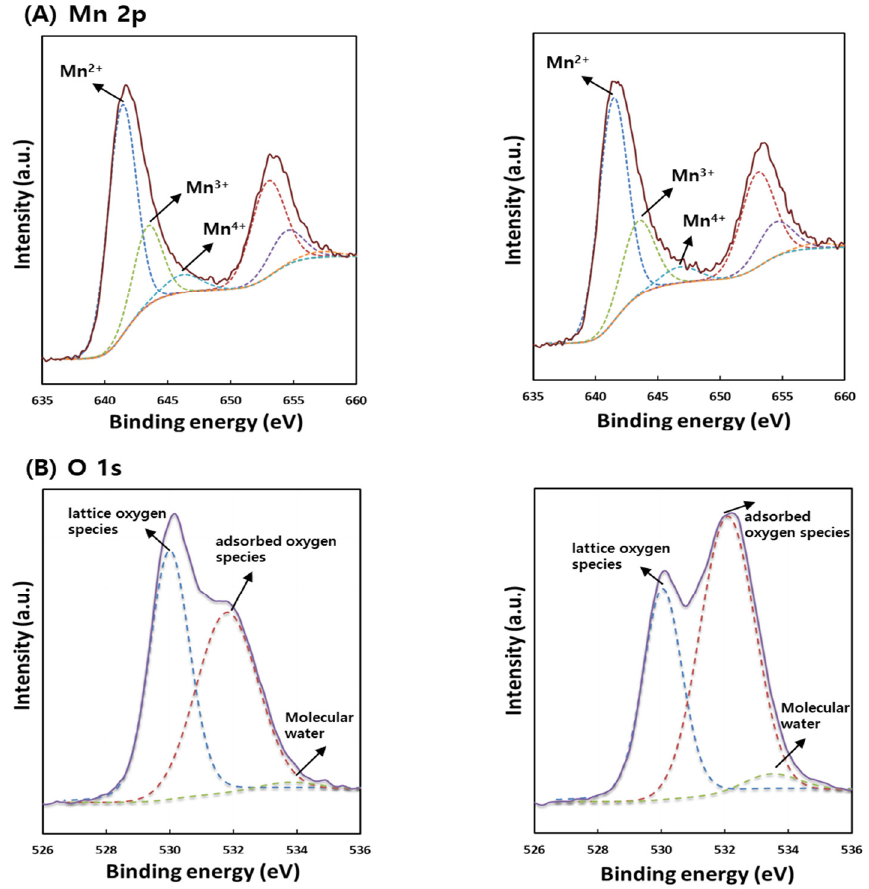
Figure 2. Curve fitting of the Mn 2p and O 1s XPS spectra. ( A ) Mn 2p of 10 wt.% Mn/NZ calcined at 350 °C and 550 °C, and ( B ) O 1s of 10 wt.% Mn/NZ calcined at 350 °C and 550 °C. Left: 10 wt.% Mn/NZ calcined at 350 °C; right: 10 wt.% Mn/NZ calcined at 550 °C.